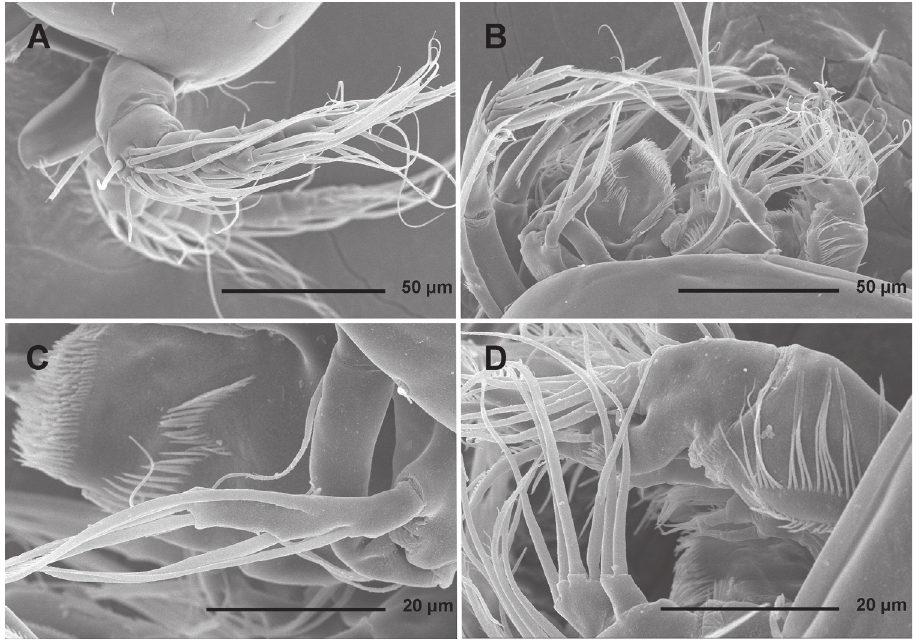
Figure 9. Stenhelia taiae Mu & Huys, 2002, scanning electron micrographs, female: A rostrum and antennulae, lateral B antenna and mouth appendages, lateral C mandibular palp and labrum, lateral D maxilla and part of maxillular palp,